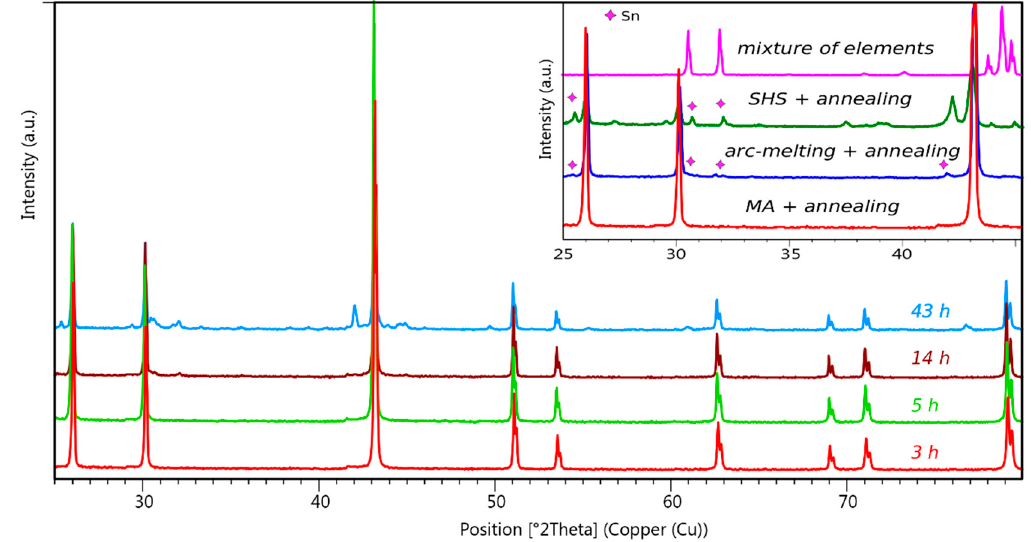
Figure 9. XRD patterns of samples prepared by MA at 400 rpm and annealed for 10 days at 750 °C. A comparison with other synthesis methods is given in the inset.